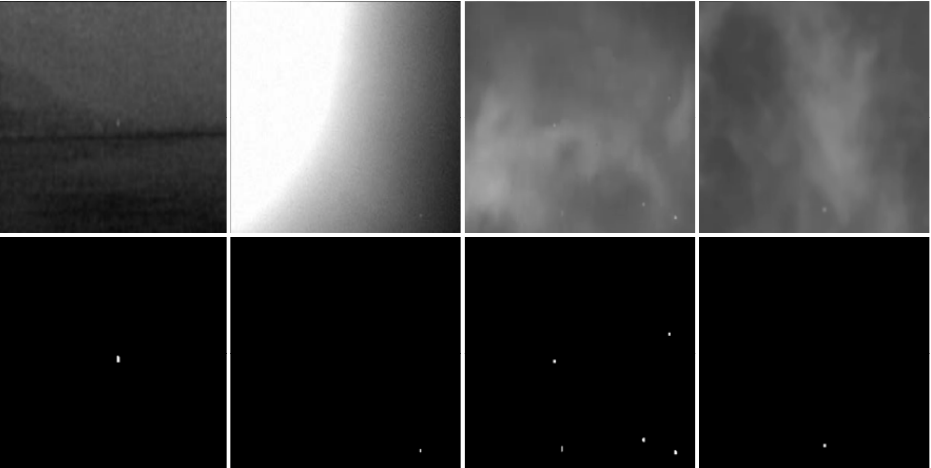
Figure 1. Examples of infrared small targets submerged in complex backgrounds that are difficult to detect accurately.